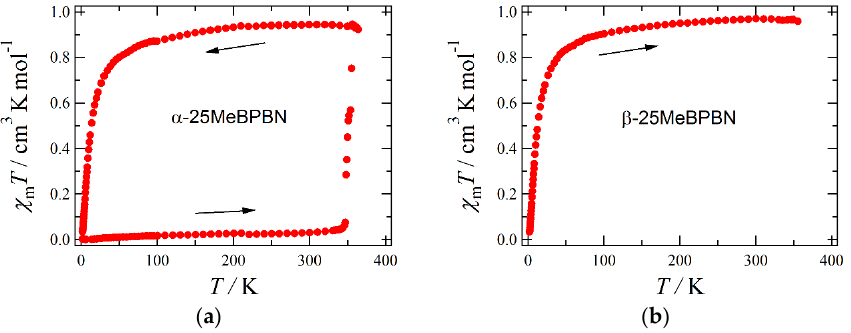
Figure 6. Temperature dependence of χ m T measured at 5000 Oe for ( a ) α -25MeBPBN on heating and then cooling and ( b ) β -25MeBPBN on heating.